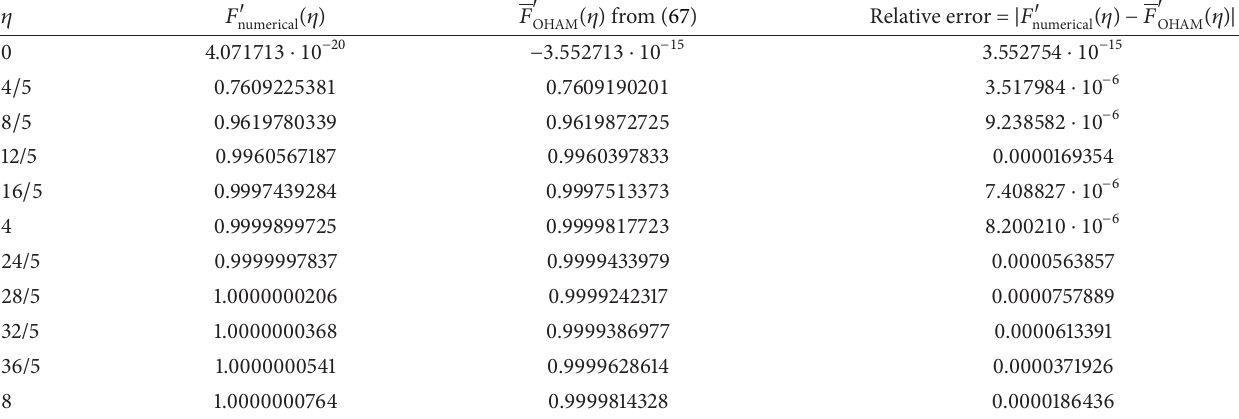
󸀠 (𝜂) obtained from (67) and numerical results for 𝛽 = 1.6